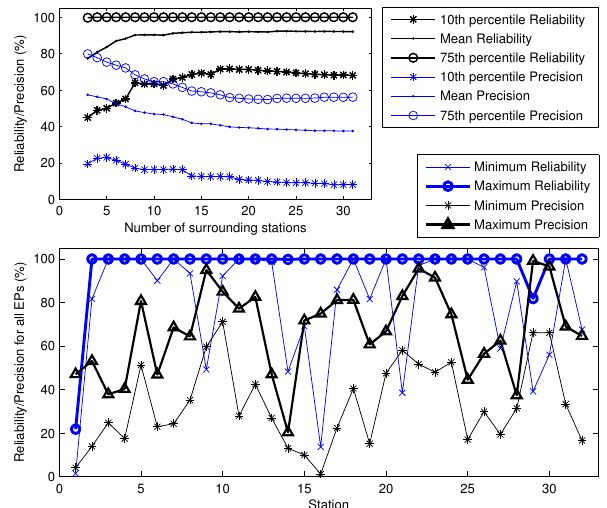
Figure 7. Reliability and precision of the FDC regionalisation, with different numbers of hydrologically similar basins included in the regionalisation (top panel) and the minimum and maximum values for each station for the chosen number of basins ( N =8, bottom